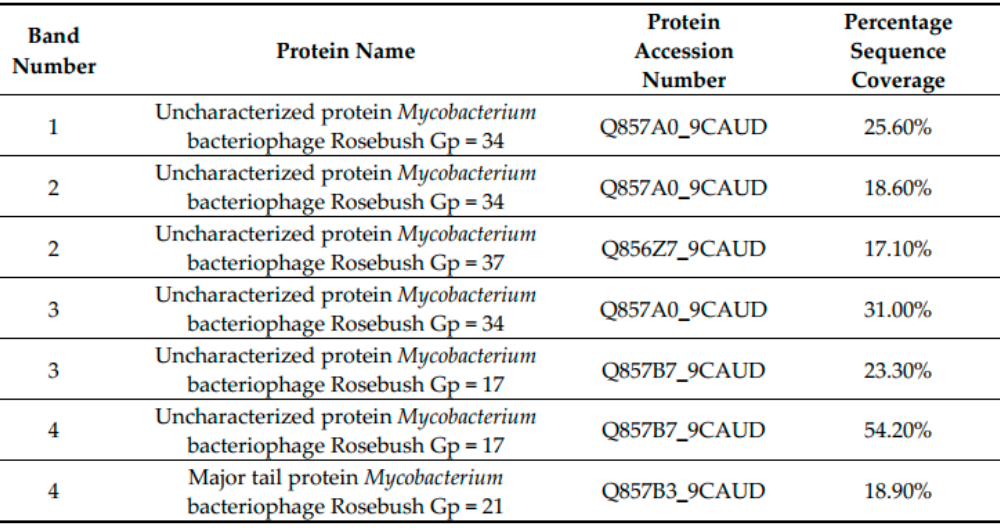
Figure 7. Mass spectrometry identification of accessory proteins in Rosebush. SDS-PAGE gel of Rosebush (top) with the bands excised for mass spectrometry highlighted by 1–4. Bottom: the results of the mass spectrometry shown for each band highlighting the Rosebush proteins with at least 15% sequence coverage. Full mass spectrometry results can be found in Tables S1–4.